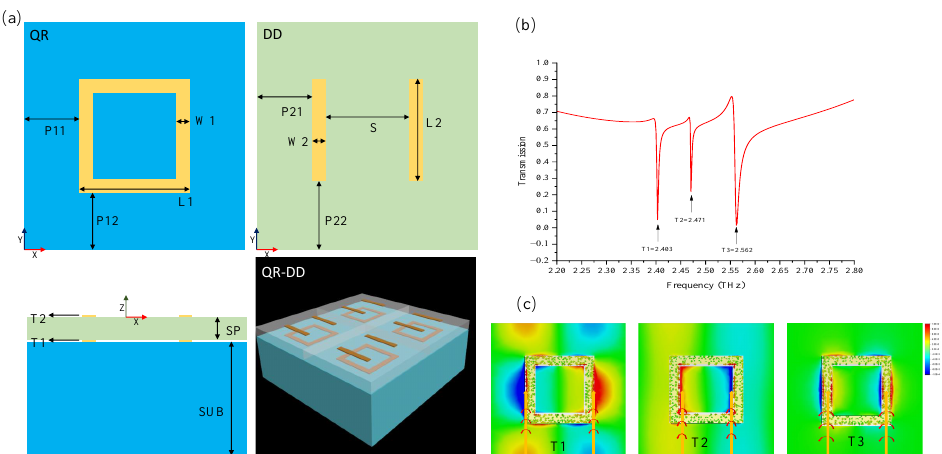
Y-axis direction, which is parallel to the polarization of the incident wave. The discussions dipoles can individually act as dark modes by designing the structural profile.